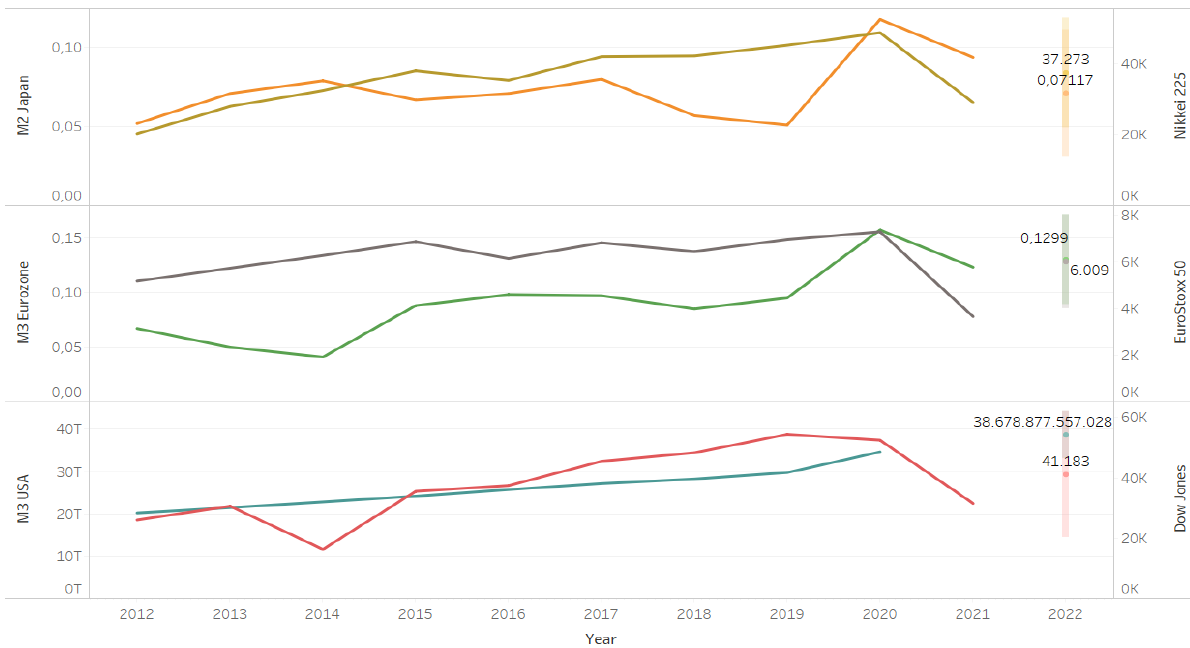
Figure 4. M2–M3 ratio with Market Capitalization and prediction. Source: own elaboration through Tableau Desktop professional edition and data from International Monetary Fund, ECB, Fed, and BOJ.